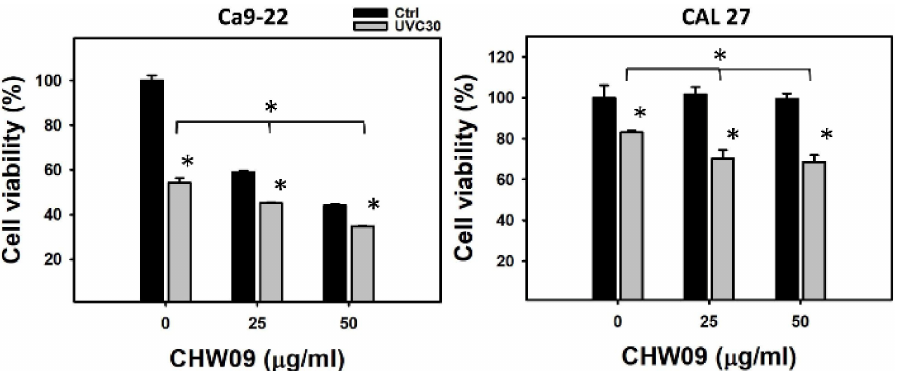
Figure 1. Cell viability (MTS assay) of oral cancer Ca9-22 and CAL 27 cells after UVC / CHW09 combined treatments. Cells were pretreated with ultraviolet C (UVC) irradiation (0 and 30 J / m 2 ) and / or post-treated with CHW09 (control, 25, and 50 µ g / mL) for 24 h. Data, mean ± SD ( n = 3 independent experiments). For multiple comparison, significance of the di ff erence was examined by one-way analysis of variance (ANOVA) and the Tukey HSD Post Hoc Test. *, p < 0.0001. * without line indicates the significance between control and UVC30. * with line indicates the significance between UVC30 / CHW09 and others.